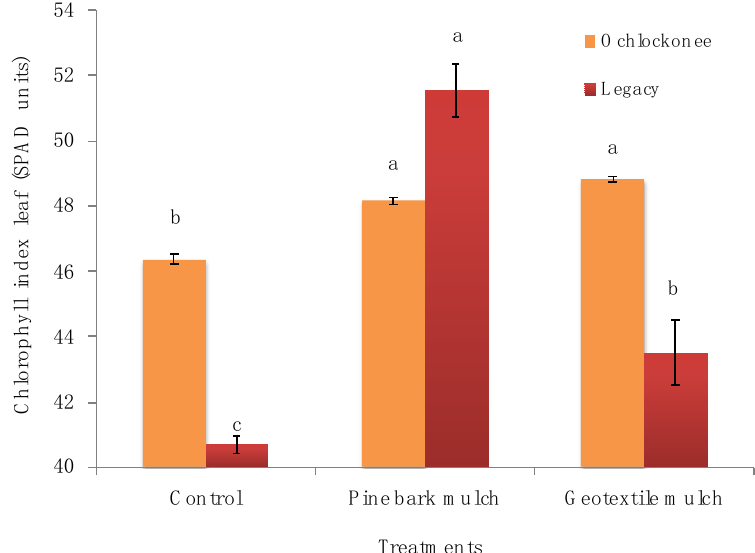
Figure 4. Effects of the different types of mulch on the chlorophyll index in leaves (SPAD units) at three times of the day. For each cultivar, different lowercase letters indicate significant differences for different types of mulch, according to the Tukey test ( p < 0.05). The vertical bars correspond to ± the standard error of the mean ( n = 9).